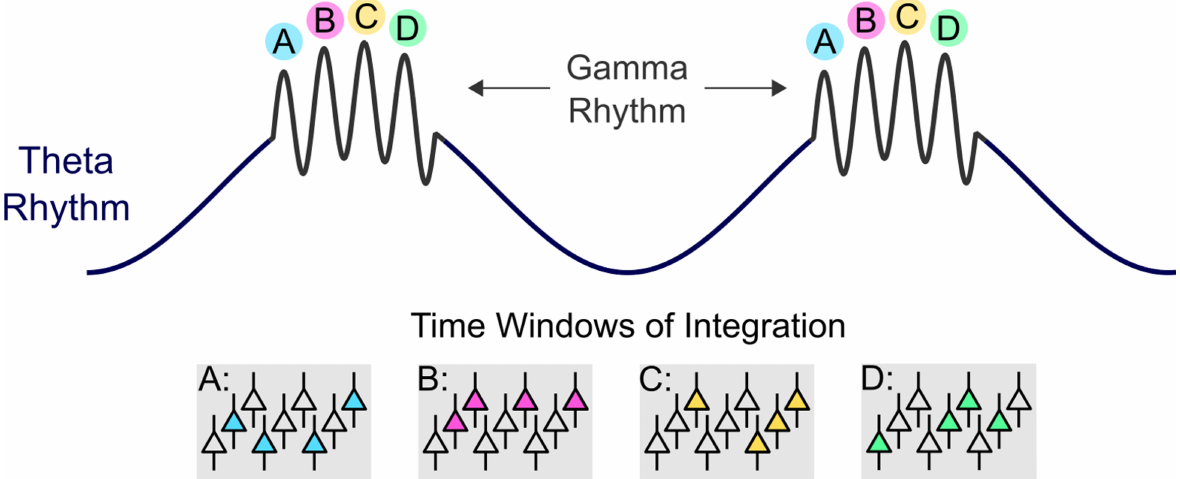
Fig 1. Theta–gamma neural coding scheme. Each gamma cycle represents the activity of local neural assemblies (represented as A, B, C, and D in the figure), each encoding a single item of information. The global theta rhythm organizes multiple gamma cycles by phase–amplitude cross- frequency coupling. According to this concept, the amplitude of the faster rhythm (e.g., gamma) increases during the certain phase of the slower rhythm (e.g.,